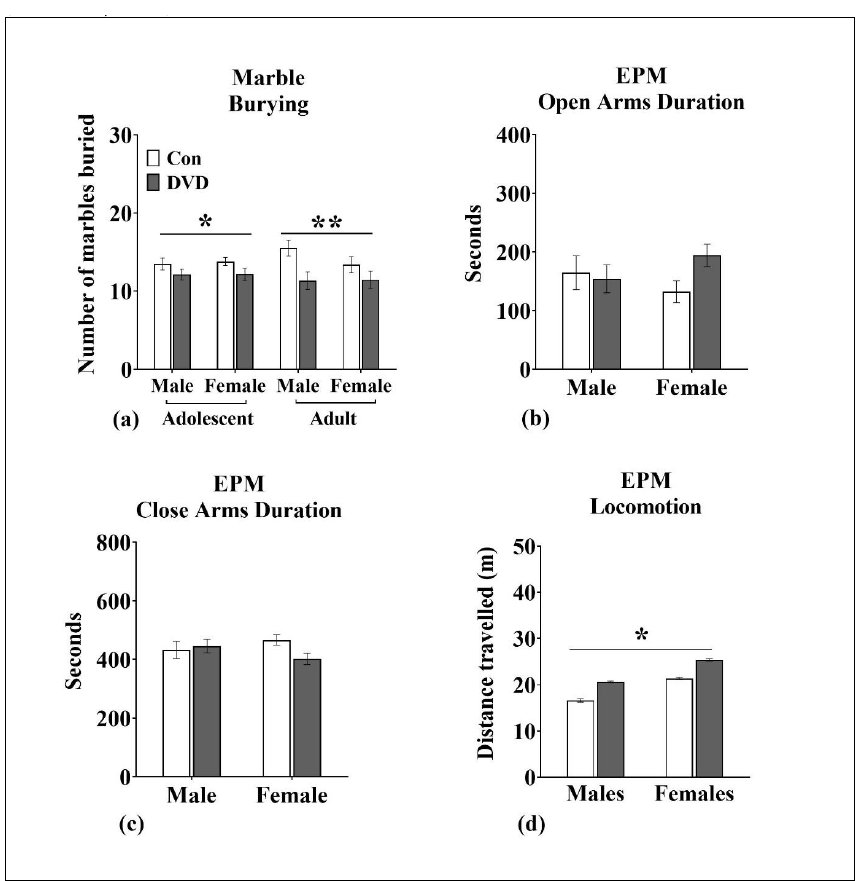
Figure 6. Marble burying and elevated plus maze assay (Cohort 3). ( a ) DVD-deficient rats from both sexes buried significantly fewer marbles than control rats as both adolescents and adults. DVD males n = 48, control males n = 47, DVD females n = 48 and control females n = 44. Results show the mean number of marble buried in 30 min of session. In the elevated plus maze. ( b ) DVD-deficiency does not a ff ect the time spent in open arms or ( c ) closed arms. ( d ) Both DVD-deficient male and female rats travelled significantly more than control rats. DVD males n = 24, control males n = 16, DVD females n = 26 and control females n = 28. Error bars show SEM, * p < 0.05 and ** p < 0.01, EPM = elevated plus